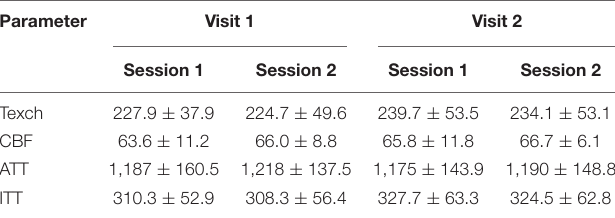
TABLE 3 | Inter-session and inter-visit mean grey matter values of CBF (ml/100 g/min), Texch (ms), ATT (ms), and ITT (ms) resulting from the extended